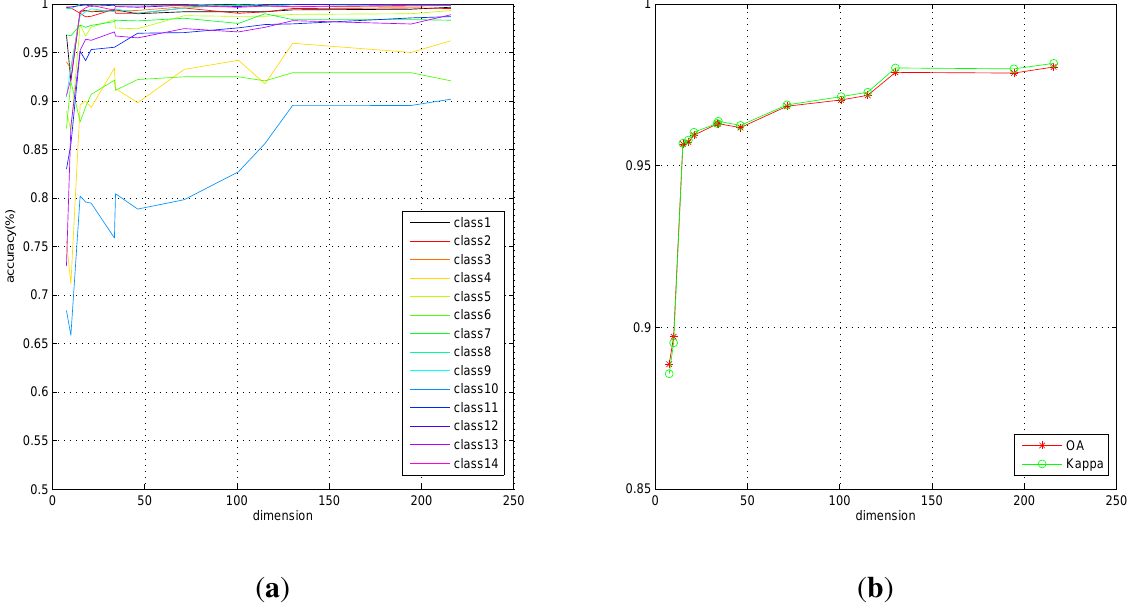
Figure 4. The accuracy of the proposed algorithm with the dimensional change of the subtensors; ( a ) correct rates for each crop; ( b ) overall accuracy and kappa